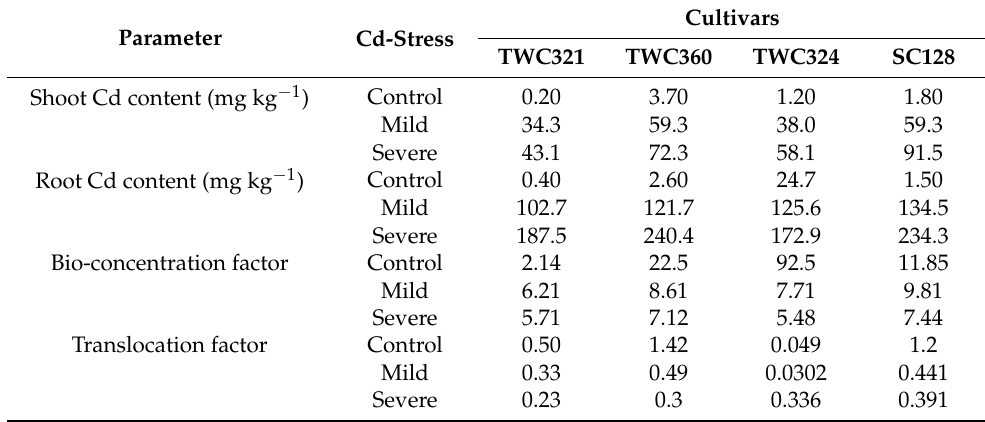
Table 1. Effect of Cd-stress (C: control, M: mild and S: severe) on shoot and root Cd content, bioconcentration factor (BCF) and translocation factor (TF) of maize cultivars. Cultivars Parameter Cd-Stress TWC321 TWC360 TWC324 Shoot Cd content (mg kg − 1 )